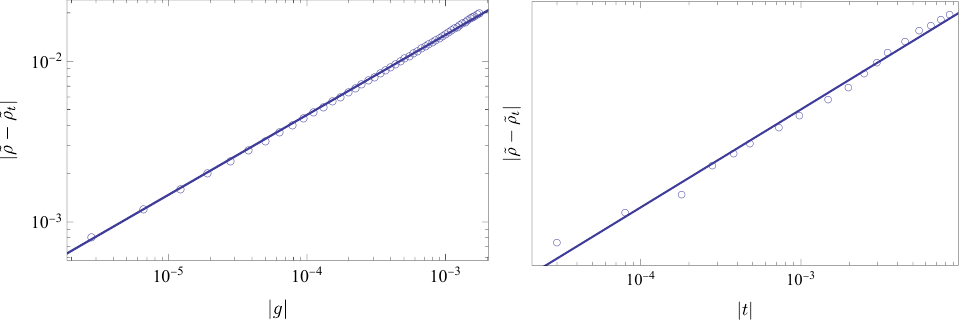
Figure 8 . The plots show the critical behaviors of the density for a path with t = 0 (left panel) and along the triple line (right